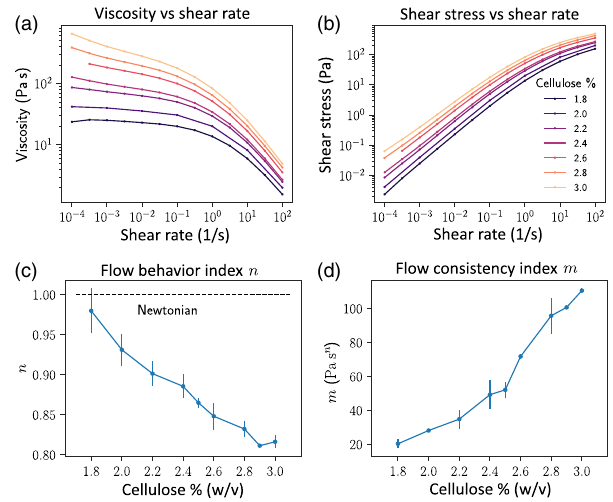
FIG. 13. (a) Shear viscosity and (b) corresponding shear stress for different polymer concentrations measured via steady-state flow tests. The fluid is weakly shear thinning for _ γ ≲ 10 − 1 s − 1 and reaches a Newtonian plateau at less than or equal to 2% polymer. For other concentrations, a power law of τ ¼ m _ γ n describes the shear stress for shear rates of _ γ ≲ 10 − 1 s − 1 . (c) and (d) plot m and n as a function of polymer concentration; the fluid becomes more non-Newtonian (shear thinning) as more polymer is